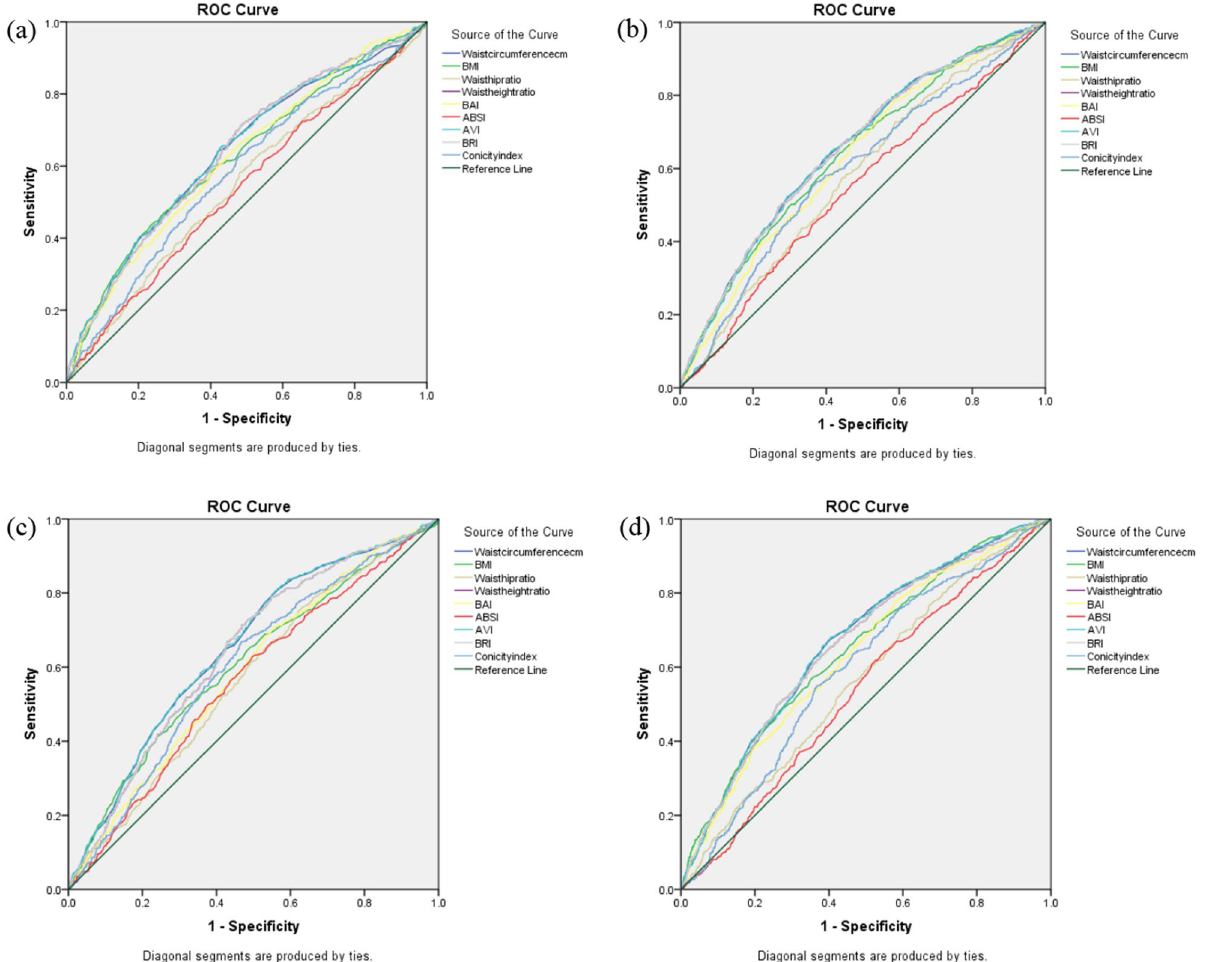
Figure 1. ( a ) ROC for systolic hypertension in males. ( b ) ROC for systolic hypertension in females. ( c ) ROC for diastolic hypertension in males. ( d ) ROC for diastolic hypertension in